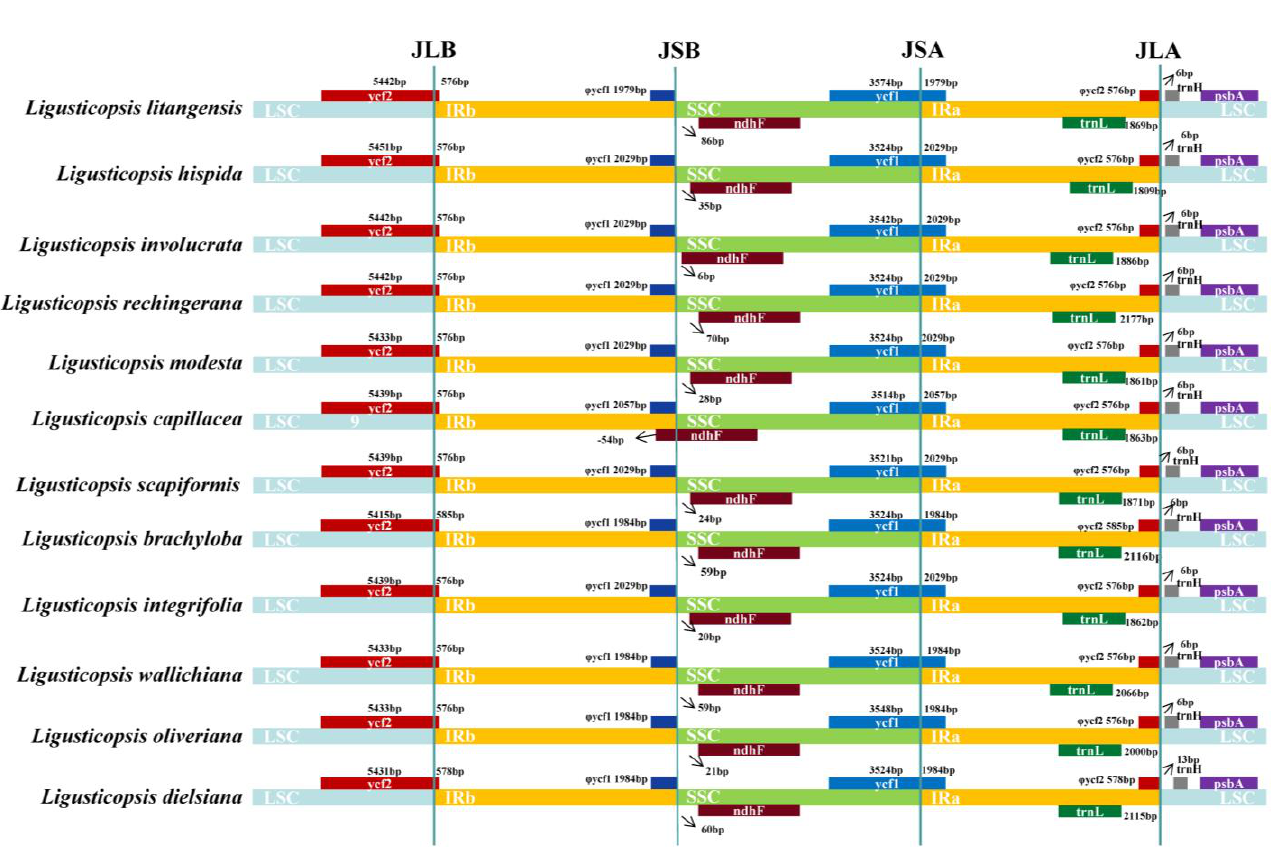
Figure 4. Comparison of LSC, SSC and IR boundary regions in 12 plastomes. The different boxes represent the location of the gene. JLA: the junction of the LSC and IRa. JLB: indicates the junction of the LSC and IRb. JSA: the junction of SSC and IRa. JSB: the junction of SSC and IRb.